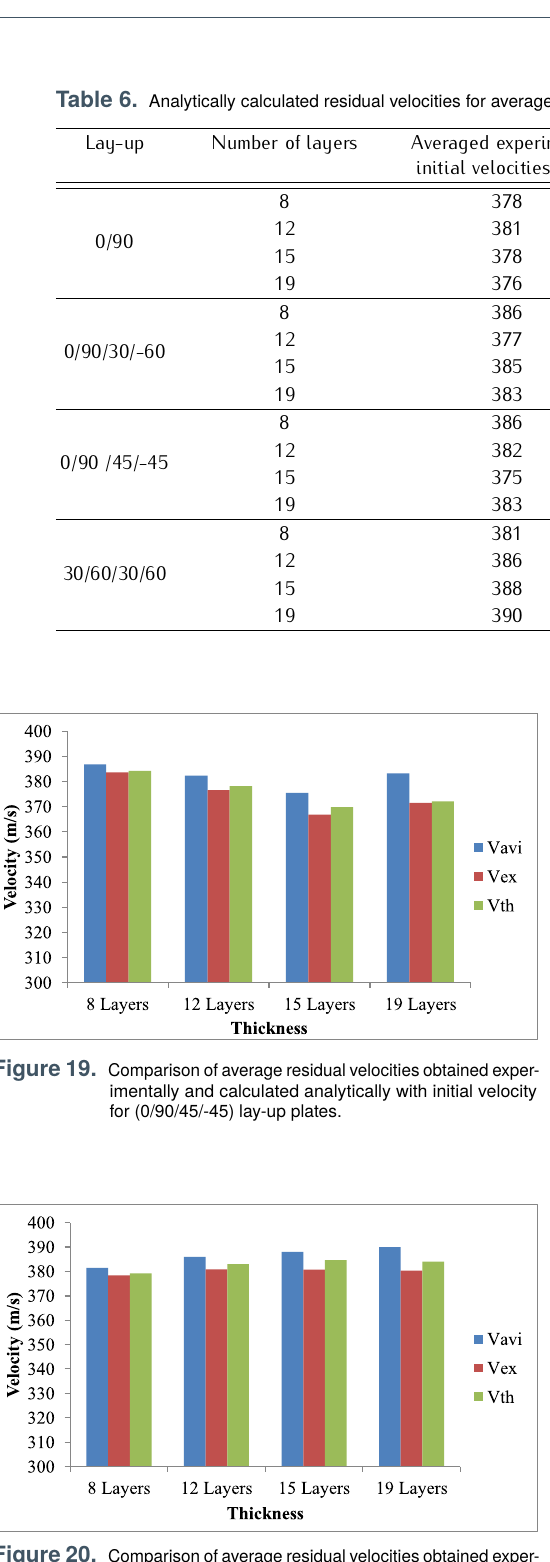
Figure 20. Comparisonofaverageresidualvelocitiesobtainedexper- imentally and calculated analytically with initial velocity for (30/-60/60/-30) lay-up.